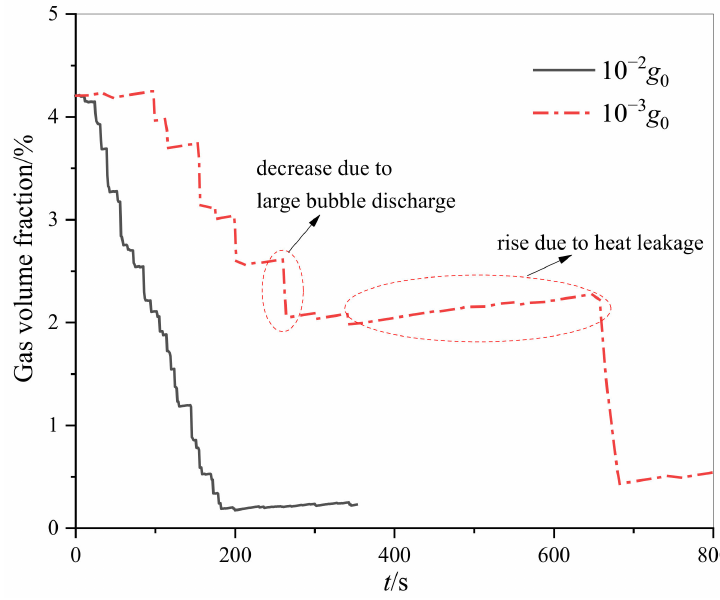
Figure 6. Gas fraction decreasing curves under − 2 g 0 and − 3 g 0 ( t 0 = 60